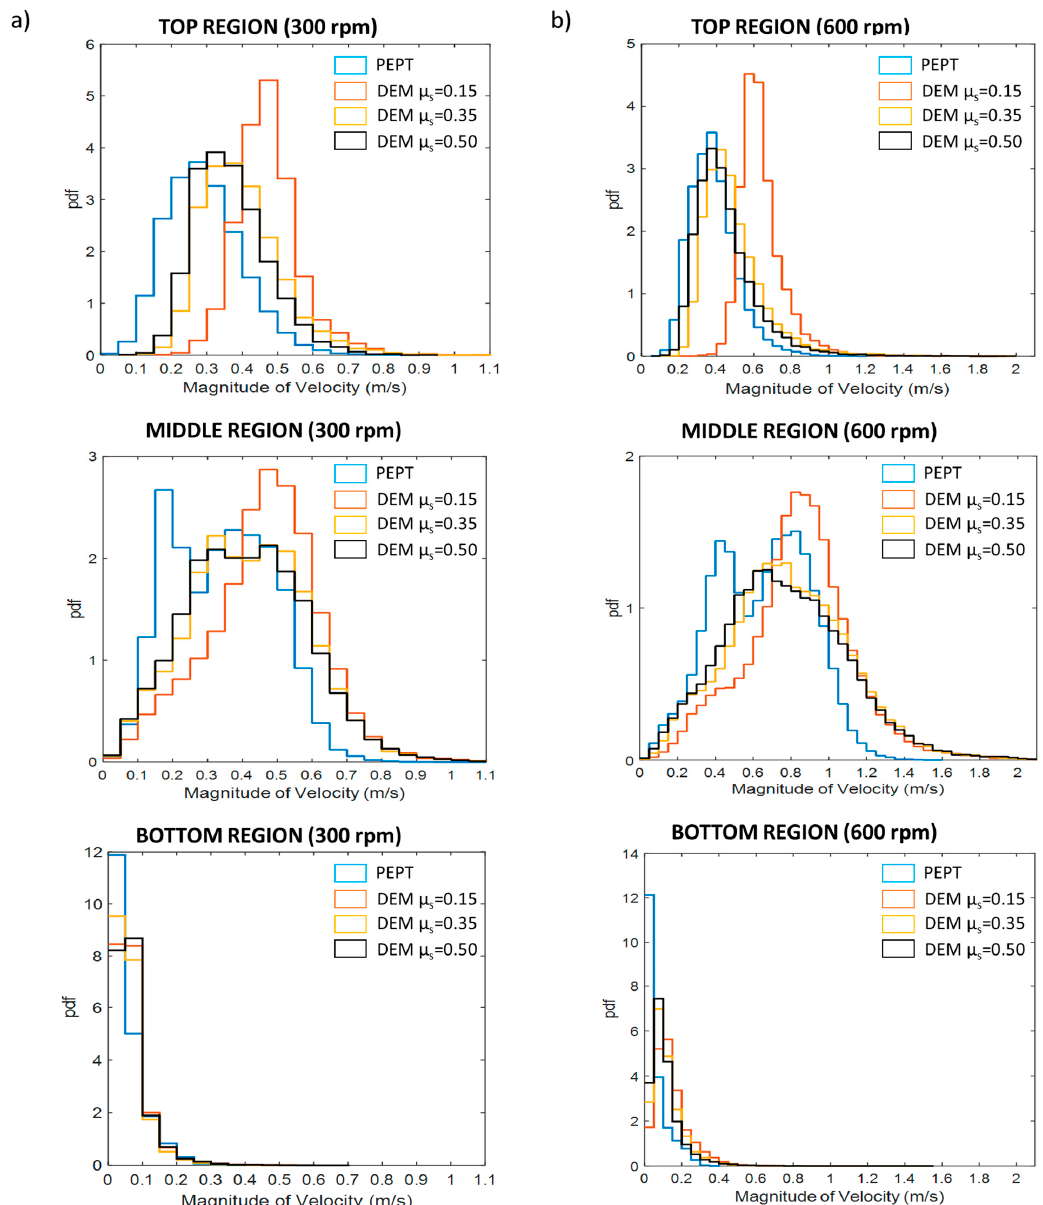
Figure 14. Probability density functions (pdf) of the velocity magnitude calculated for the top, middle and bottom regions. Comparison between PEPT data and DEM simulations as function of the static friction coefficient for the impeller speed of ( a ) 300 rpm and ( b ) 600 rpm.